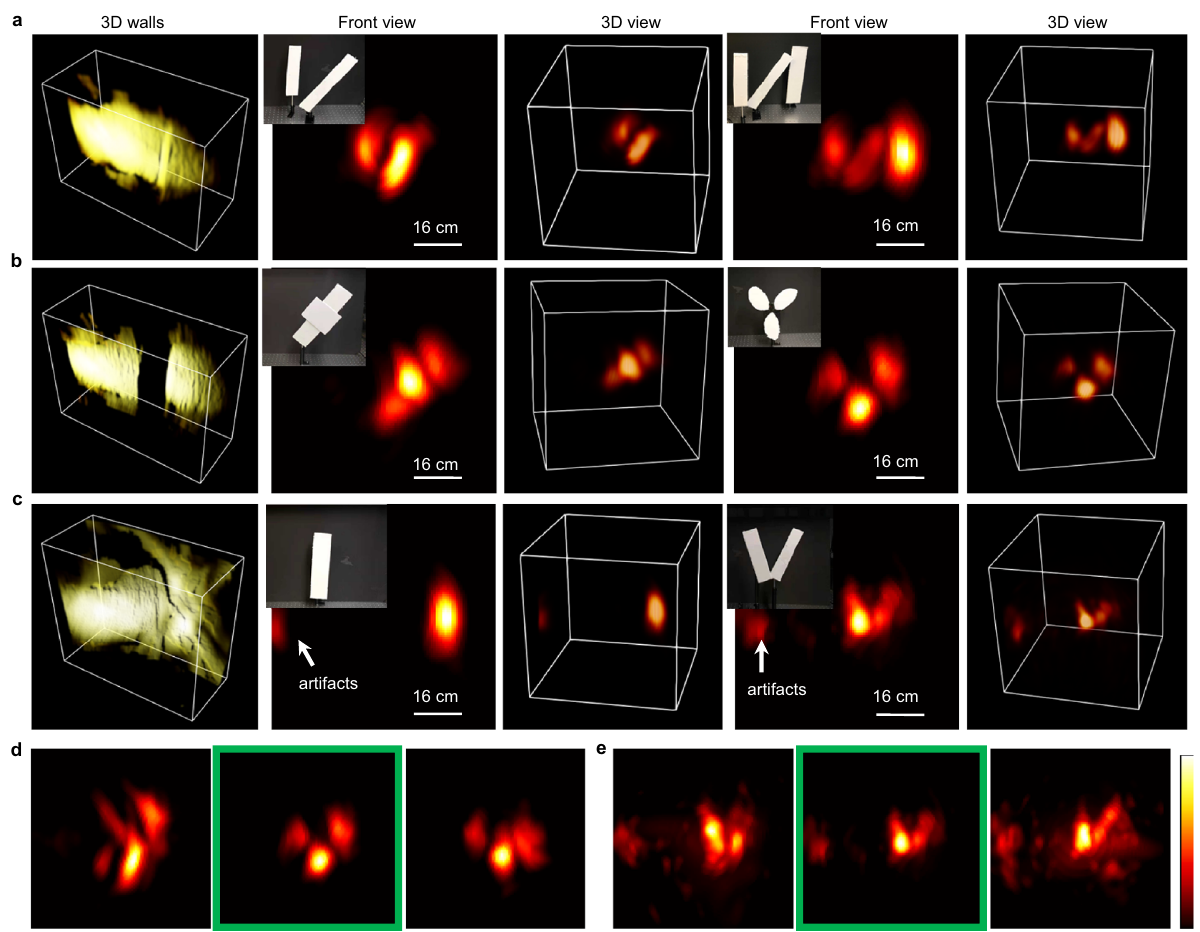
Fig. 4 NLOS imaging by CLIP-ToF. a – c Imaging with planar, disconnected, and curved surfaces, respectively. From left to right are the fl ash LiDAR imaging of the relay surfaces, and two example hidden objects rendered as a projection image in the front view, and a 3D (three-dimensional) point cloud. Ground truth photographs of the object are shown in the inset of the front view image. d , e Reconstructed NLOS images for the disconnected and curved surfaces, respectively, with defocus errors on the relay wall, and those recovered with extended depth of fi eld (highlighted by the green box). The quality of reconstruction degrades when the camera ’ s extended depth of fi eld is